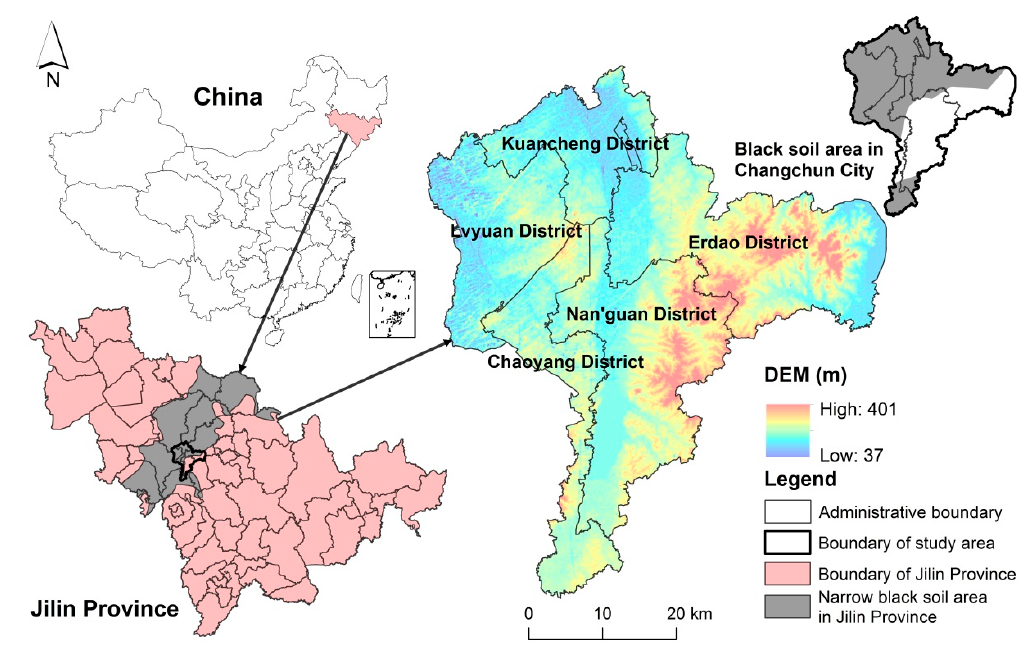
Figure 1. Location of the study area.